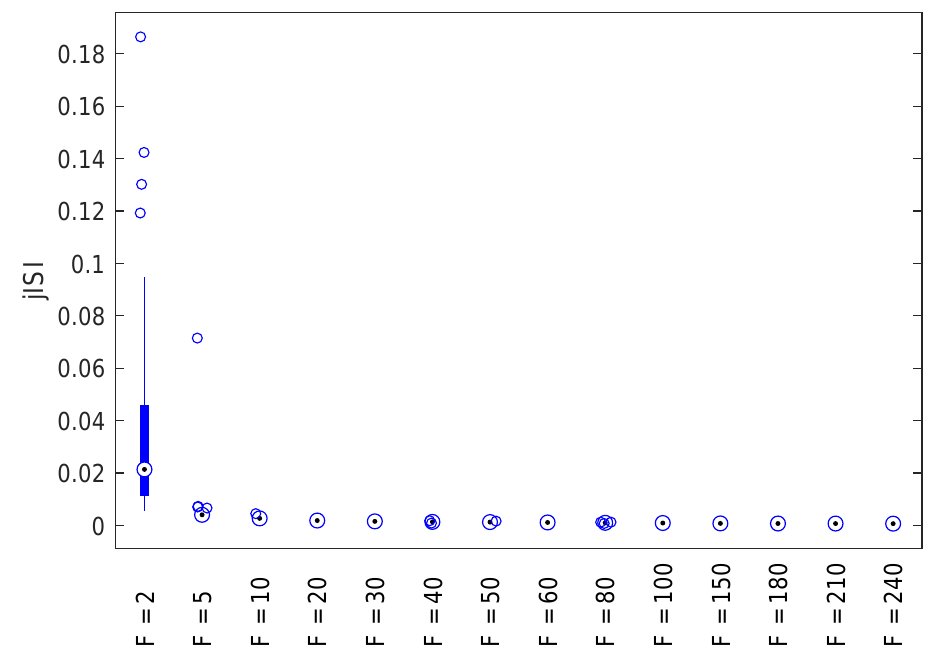
Figure 7. Statistical performance analysis for IVA with different SCV dimension.